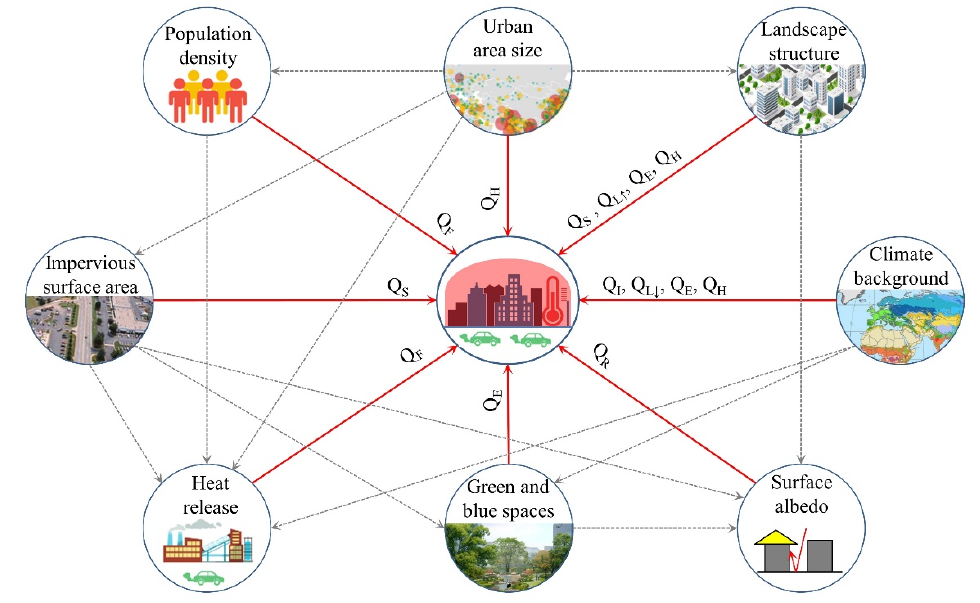
Figure 5. Potential impacts of the studied factors on SUHI’s variability among cities. The red solid and gray dashed arrows represent the direct and indirect effects, respectively. Energy components influenced by these factors directly were listed above the arrows.